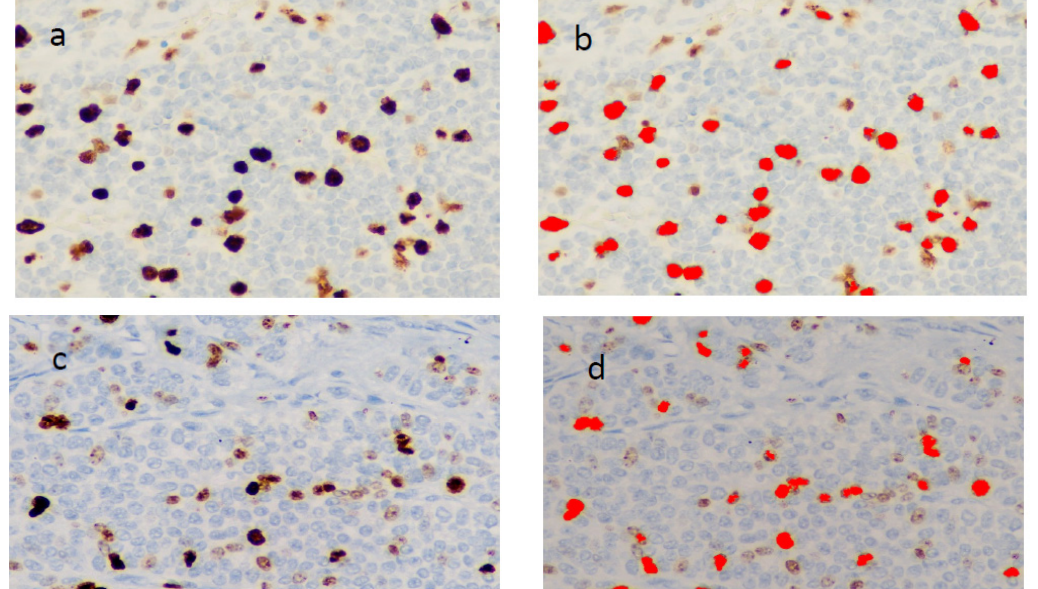
Figure 2. Evaluation of Ki67 proliferation index: in ( a ) and ( c ) immunostaining with Ki-67, 40× objective. In ( b ) and ( d ) the calculation was performed using specialized software, tumor nuclei considered positive for Ki-67 are indicated in red. Table 2. Correlation among the measure of cellular proliferation.